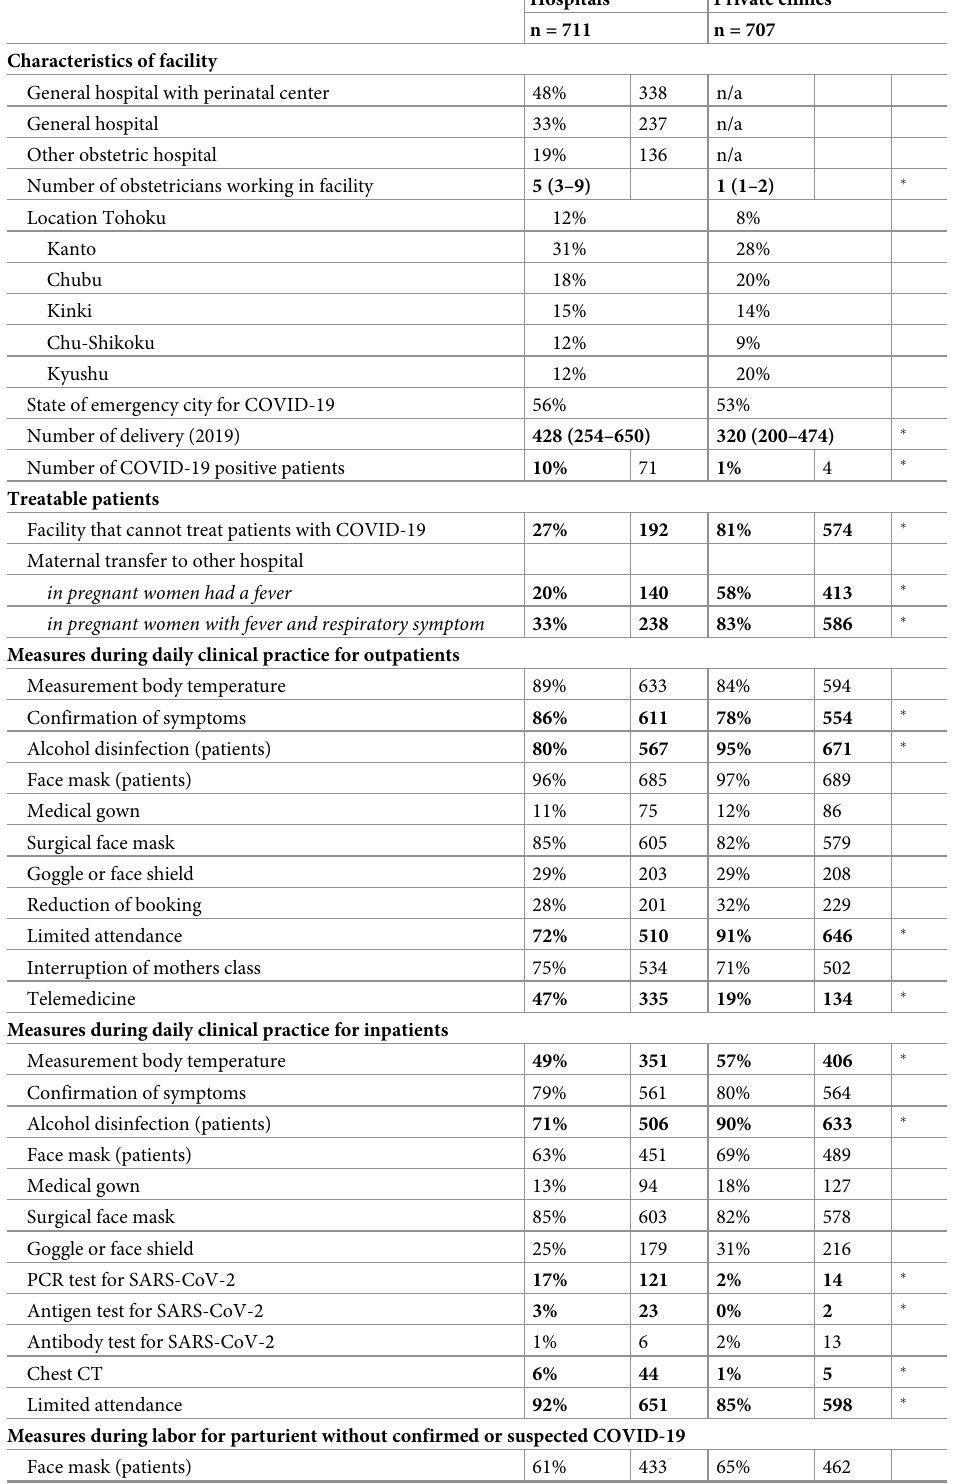
Table 1. Characteristics and preventive measures in hospitals and private clinics in